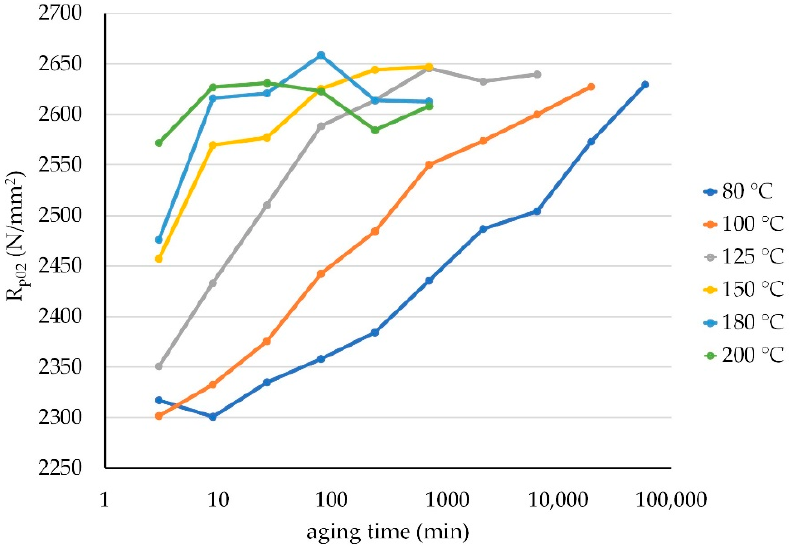
Figure 2. Yield strength vs. aging time (Ø0.71 wire, 80–200 °C). Yield strength was also determined in as-drawn conditions. The mean value of R p02 without heat treatment is 2292 N/mm 2 .